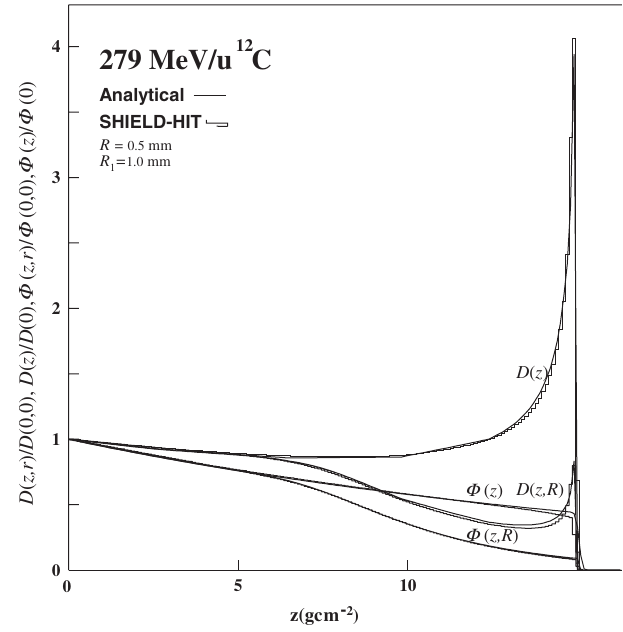
FIG. 3. Depth variation of the primary 12 C ions in broad and pencil beam in water described by analytical calculation of the absorbed dose and fluence [Eqs. (27)–(29)]. The histograms are SHIELD-HIT Monte Carlo for comparison. The reduced range straggling and higher stopping power of the lower energy 12 C beam result in a higher Bragg peak dose close to the central axis relative to the primary 7 Li ions, cf. Fig. 1. The depth fluence curves for the narrow and broad beams follow the shape of the depth fluence curve in the plateau region owing to the small variation of the mean stopping power. Only at the very end of the primary particle range is the loss in fluence accompanied by a compensating increased energy loss towards the Bragg